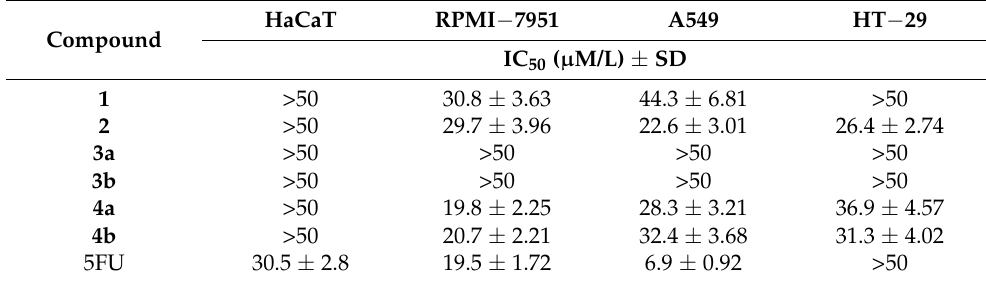
Table 1. IC 50 (μΜ) values of 4a , 4b, and their intermediates against normal and cancer cell lines; compounds displaying IC 50 values above 50 μM were considered not effective and , therefore, the specific values were not shown.